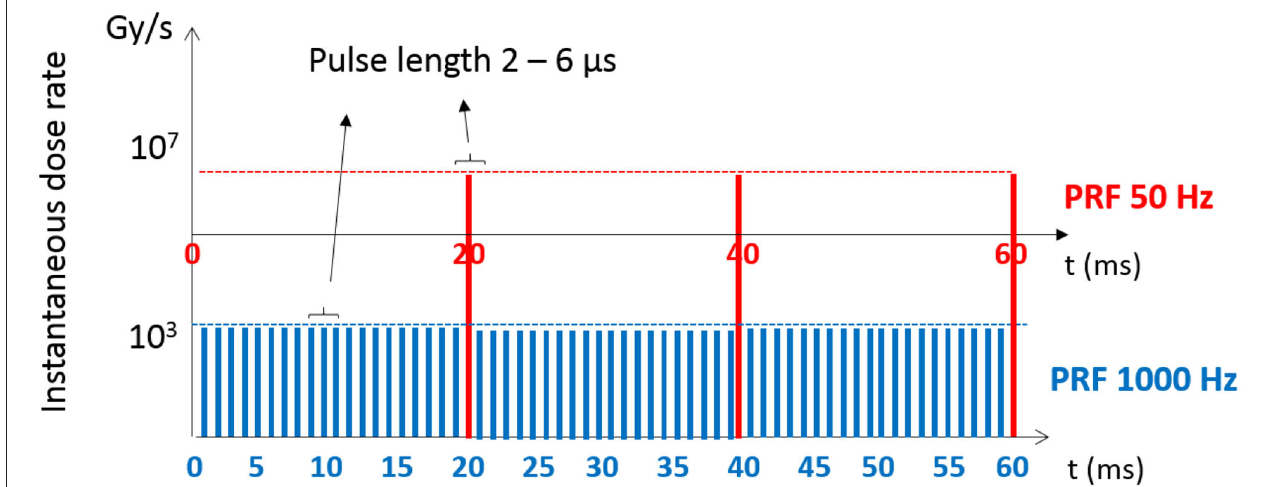
FIGURE 1 | Flash instantaneous dose-rate for an average dose-rate of 100 Gy/s delivered by a LINAC working at two different PRF: 50 and